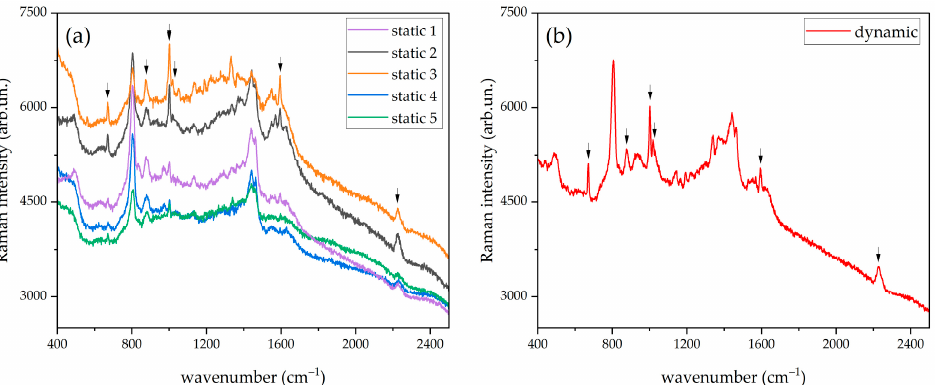
Figure 7. ( a ) SERS spectra of PER 1 × 10 − 4 M recorded in static mode in different spots or ( b ) with the spinning-cell setup (dynamic mode). 632.8 nm excitation laser, 5 mW incident power, 10 s exposure time (5 averages), 20× objective. All the spectra are reported with no background subtraction and no normalization. The main PER peaks are highlighted by arrows.